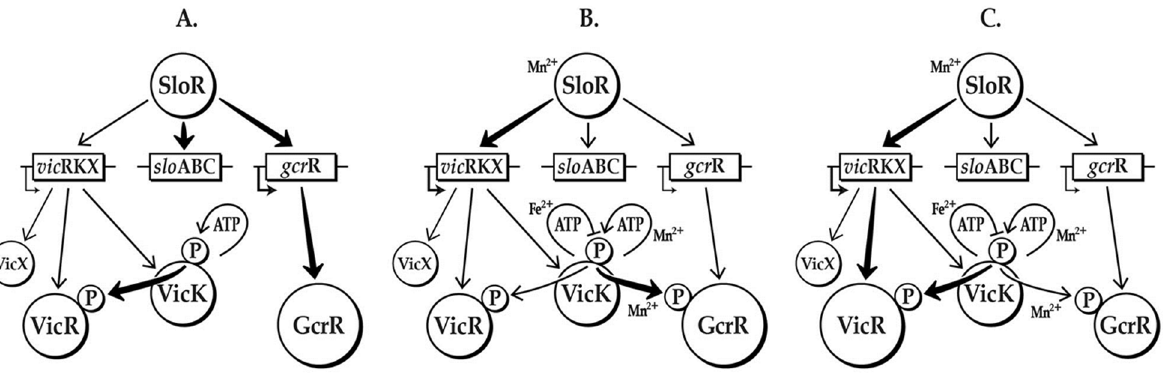
Fig. 7. In vitro model of manganese-independent (A) and –dependent cross-regulation involving S. mutans SloR, VicRK and GcrR. A) In the absence of Mn 2 + (approximating conditions of free-floating planktonic cells) S. mutans gcrR expression is de-repressed (VicR expression is not induced in the absence of Mn 2 + ). Even though GcrR is the more abundant substrate, VicR is the favored species for VicK phosphorylation under these conditions. B) During this so-called ‘‘transition stage’’ (approximating conditions of an early biofilm) a ‘‘spike’’ in Mn 2 + renders GcrR (still the predominant species) the favored substrate for phosphorylation by VicK, but only transiently. C) As the biofilm matures and Mn 2 + concentrations increase, SloR is activated to repress gcrR expression, thereby reducing the availability of GcrR as a substrate. The activated SloR-Mn 2 + complex encourages vicR expression, and hence VicR becomes the favored substrate for VicK phosphorylation once